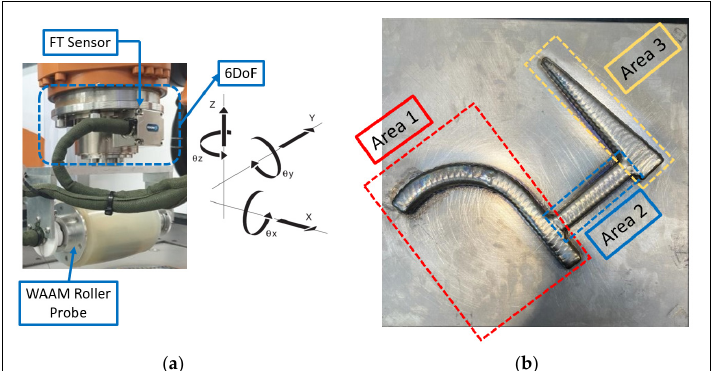
Figure 6. Experimental setup: ( a ) robotic setup with a 6 DoF FT sensor and a WAAM roller probe for NDE inspection mounted as an end effector; ( b ) WAAM component consisting of three sections with three embedded defects .